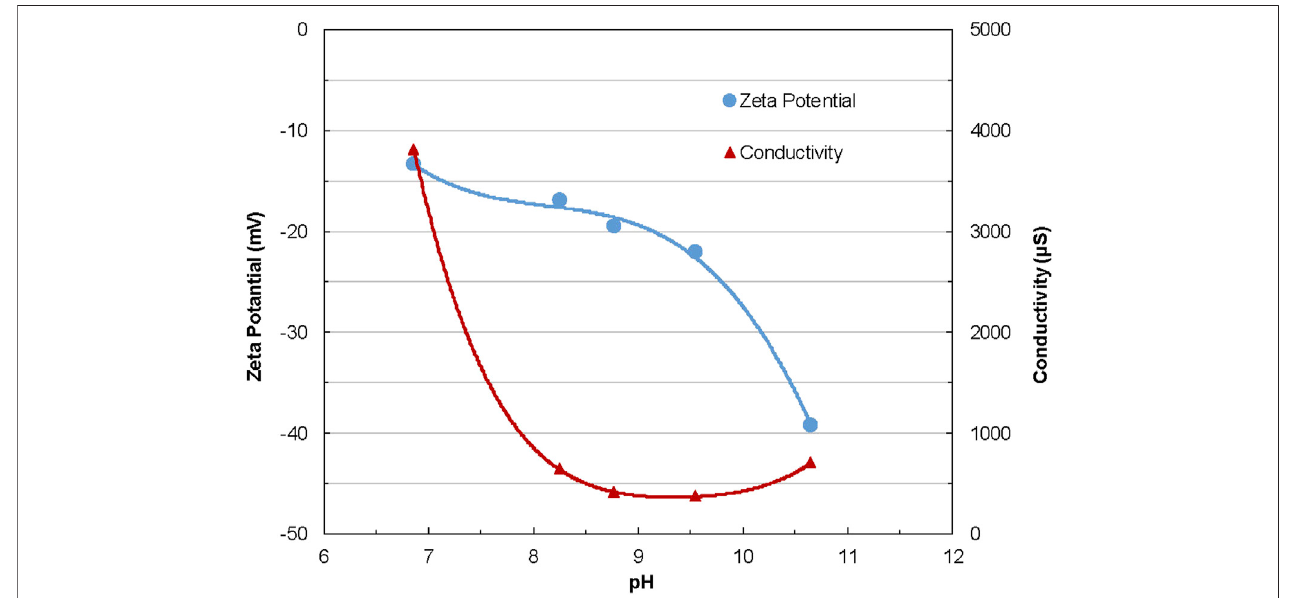
FIGURE 2 | Conductivity and the zeta potential pro fi le of the tailings